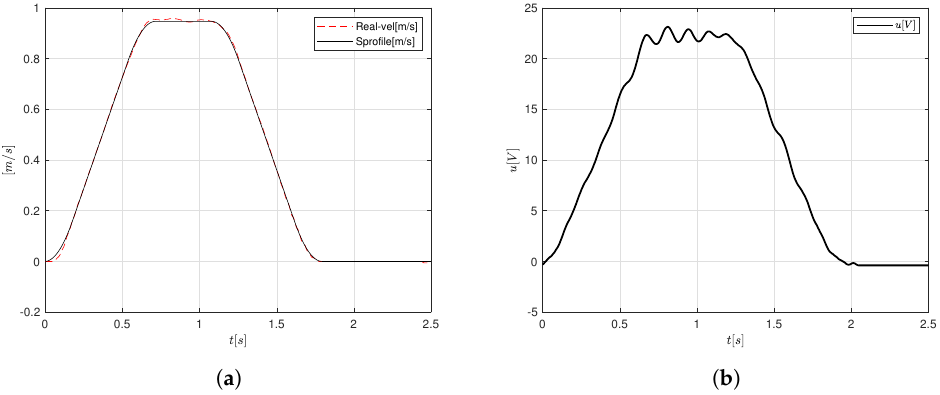
Figure 16. S-curve velocity profile implementation adding a cylindrical load of 1.9 kg ( a ) velocity and ( b ) control signal.